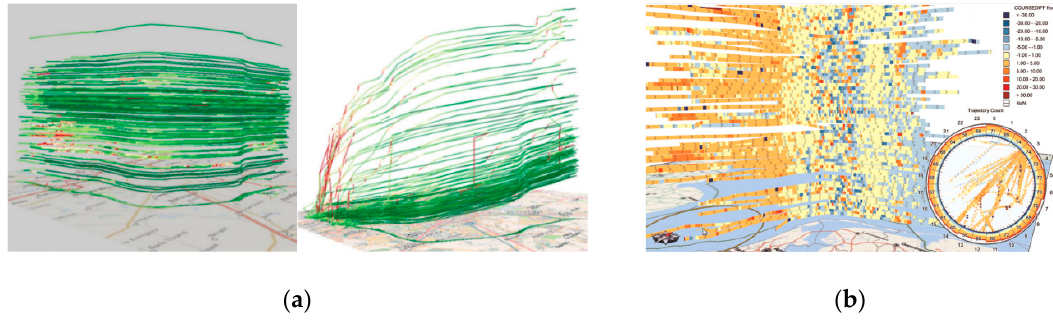
Figure 10. Examples of trajectory-wall visualization: ( a ) comparison between trajectory wall and